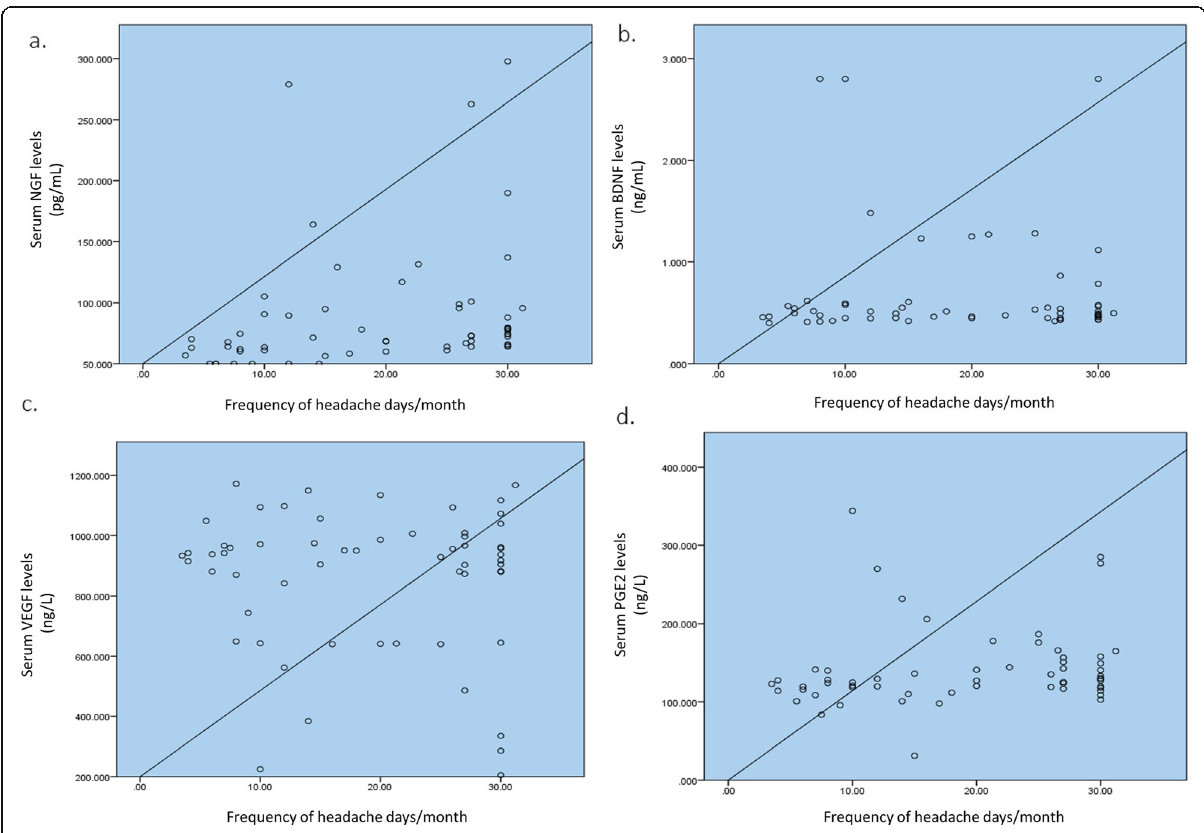
Fig. 2 Correlation between headache frequency and Serum levels of NGF, BDNF, VEGF and PGE2. A NGF ( B ) BDNF ( C ) VEGF ( D ) PGE2; NGF: nerve growth factor; BDNF: brain-derived neurotrophic factor (BDNF); VEGF: vascular endothelial growth factor; PGE2: prostaglandin